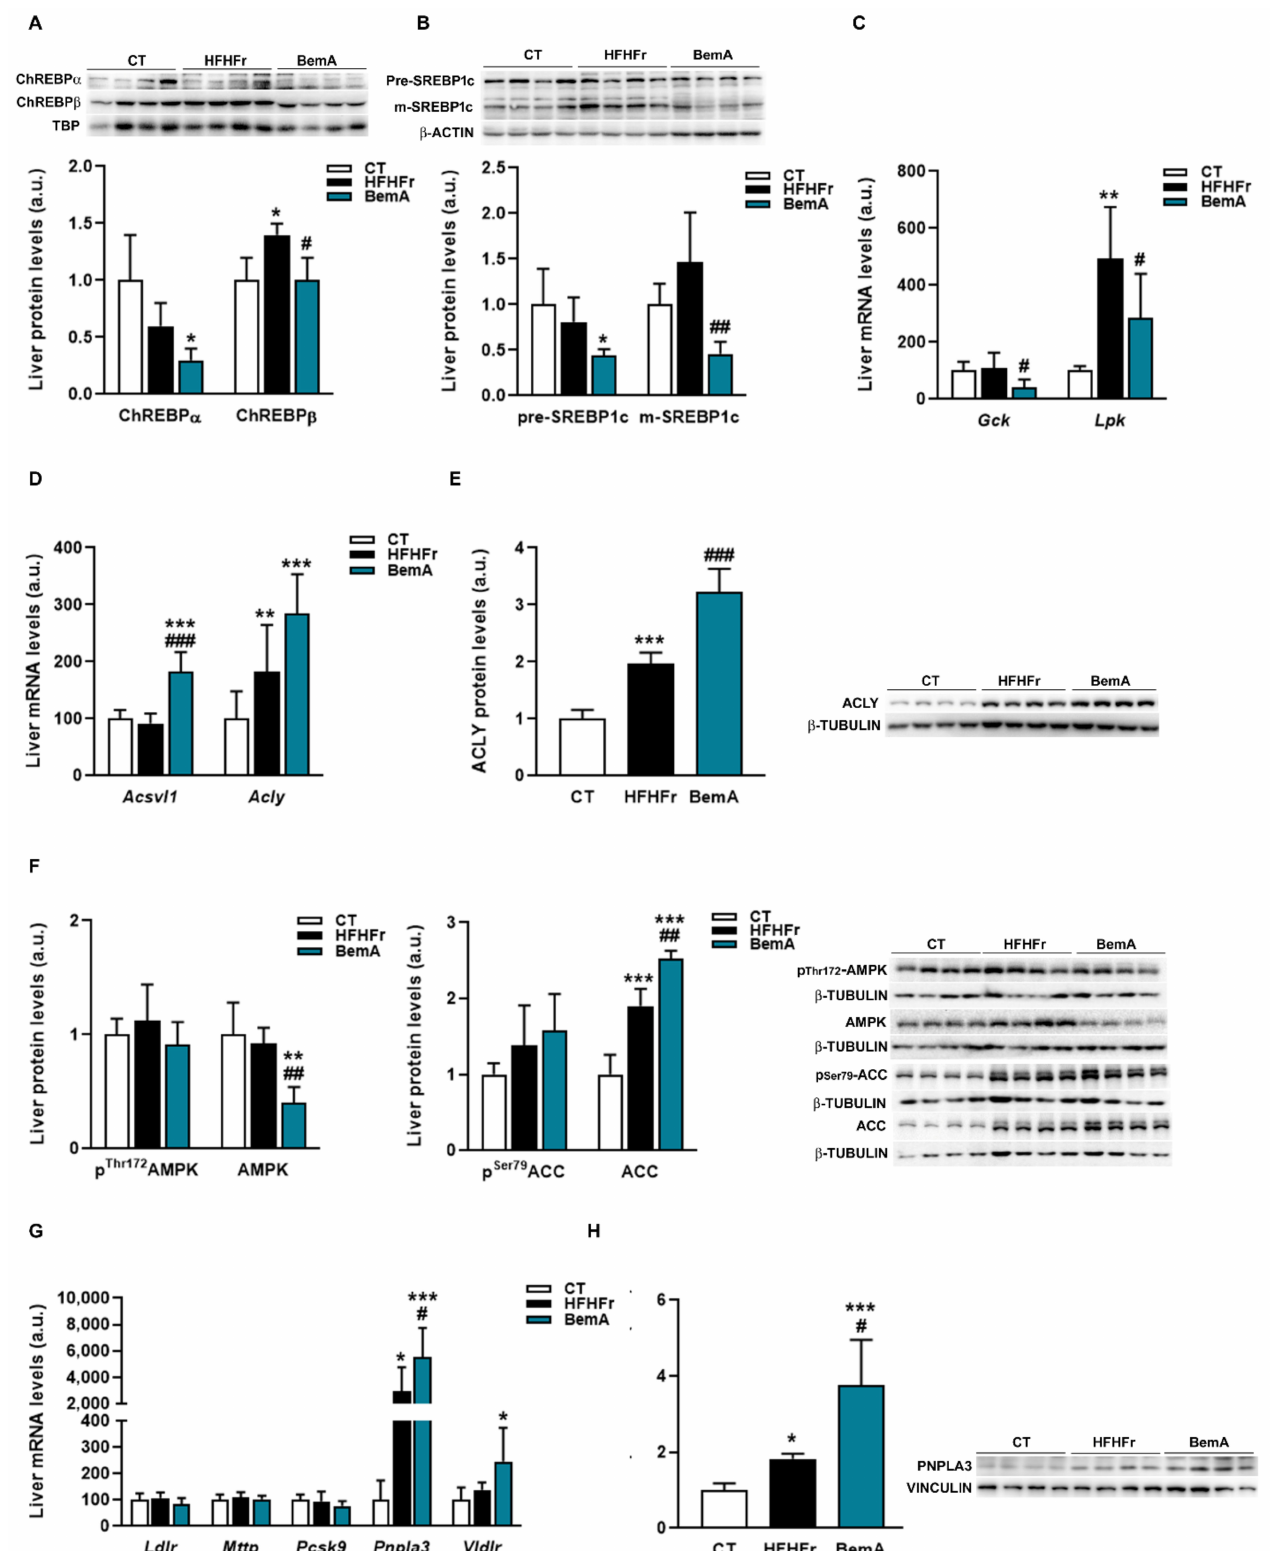
Figure 6. Effects of bempedoic acid on the expression of proteins controlling de novo lipogenesis and triglyceride trafficking. ( A ) Protein levels of ChREBP α and β , in nuclear extracts prepared from livers of control (CT), high-fat, high-fructose (HFHFr), and bempedoic acid (BemA)-treated